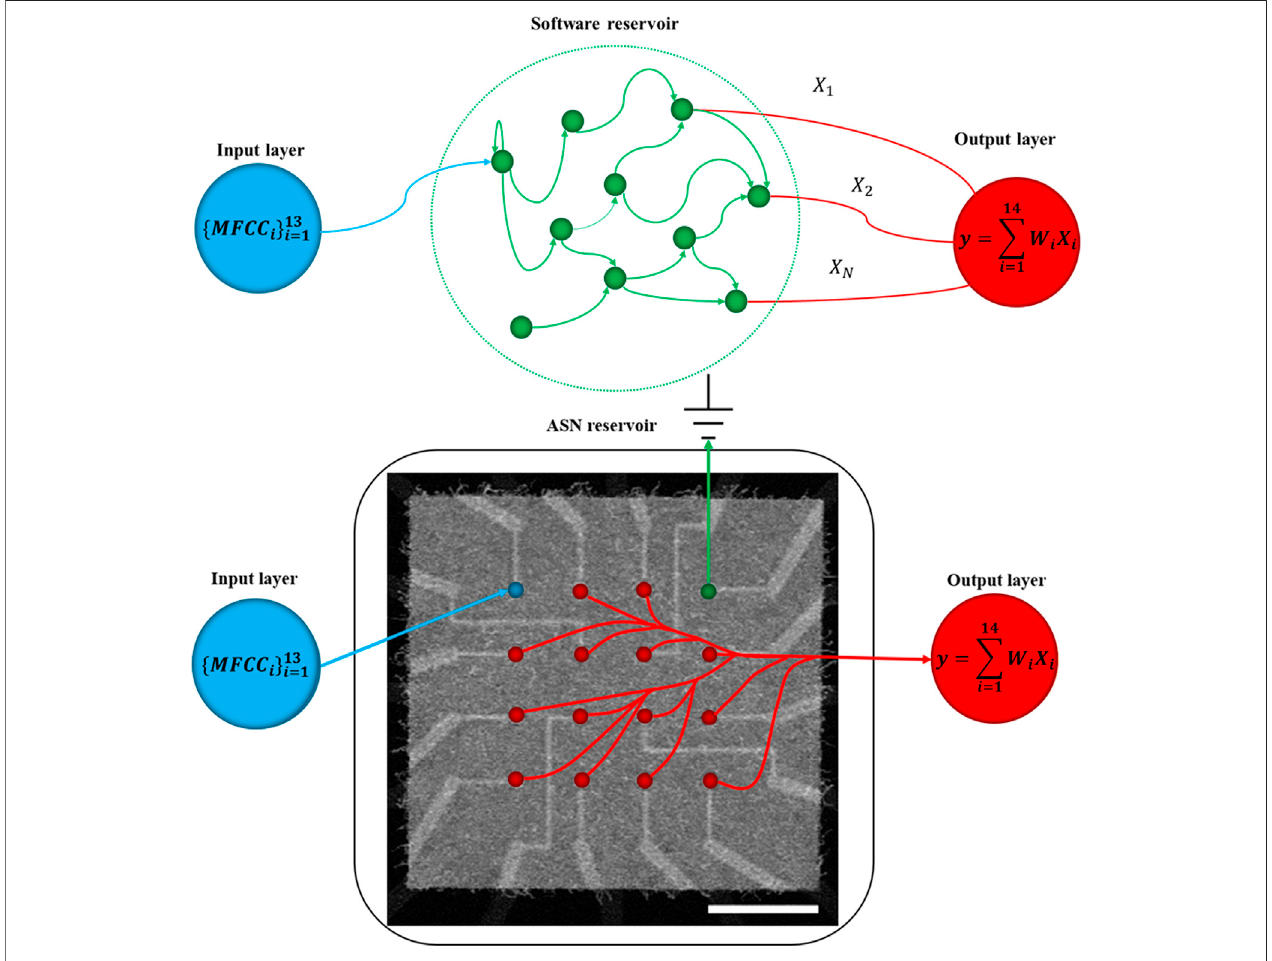
FIGURE 2 | Overview of a traditional software-based reservoir (top) in contrast to the ASN acting as an in-materio reservoir (bottom) , in which 13 MFCC ’ s are sequentiallydeliveredtotheASNintheformofatime-varyingvoltagetoasingleelectrode.Utilizingphysicalnodesenableshardwareaccelerationatalowerpowercost. Simultaneous, real-time voltage measurements are carried out at each of the remaining 14 electrodes and provided to an output layer for regression analysis.